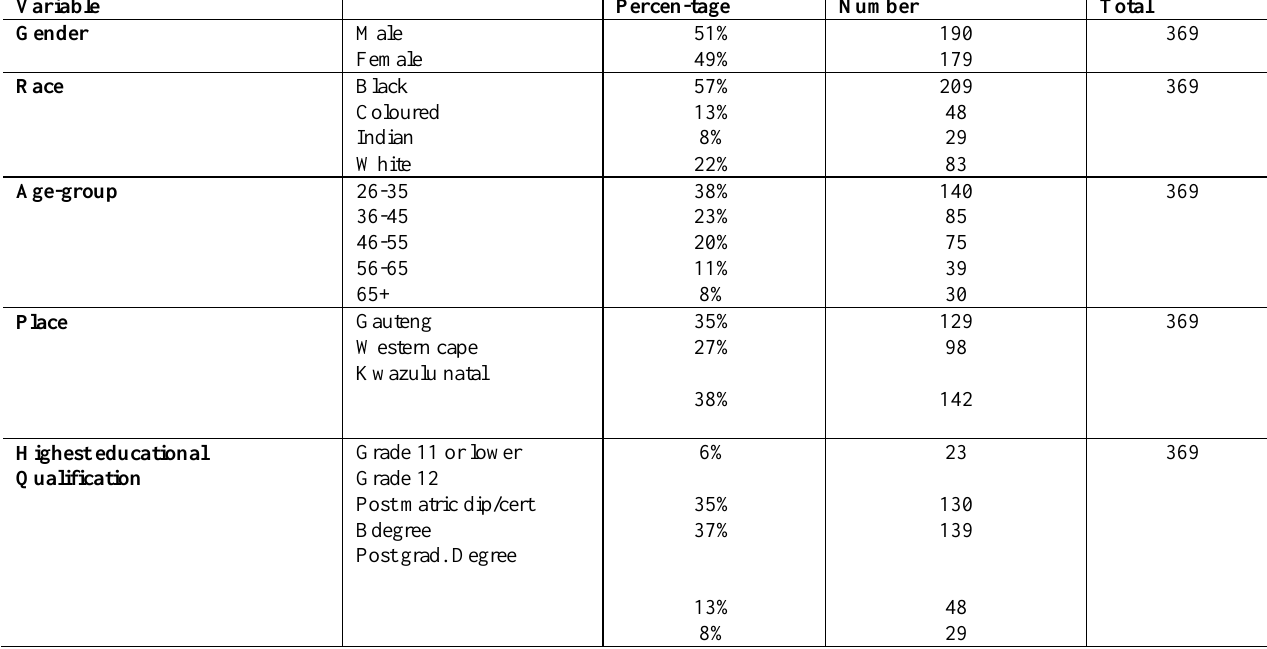
Table 1: Distribution according to demographic details Variable